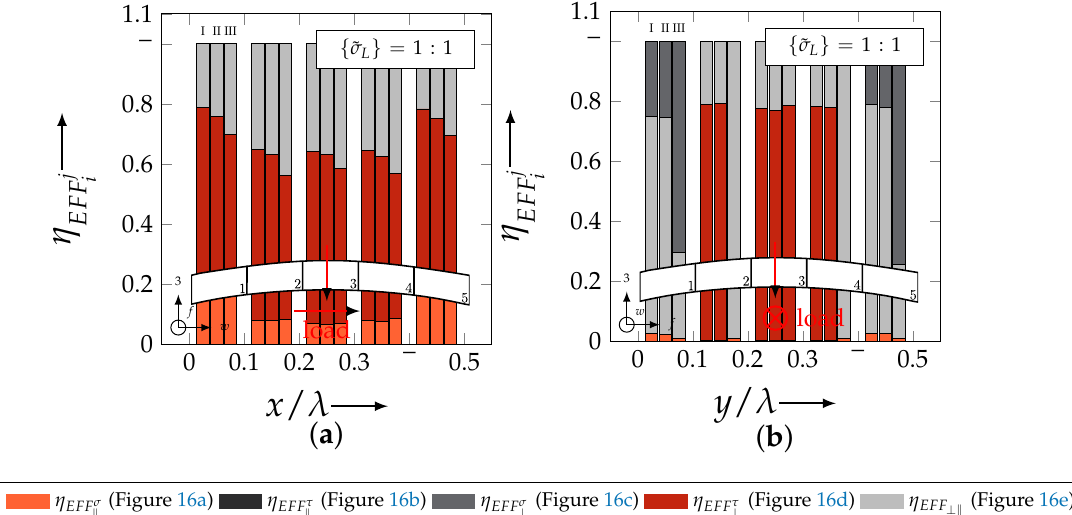
on the resultant stress effort for EFF j i